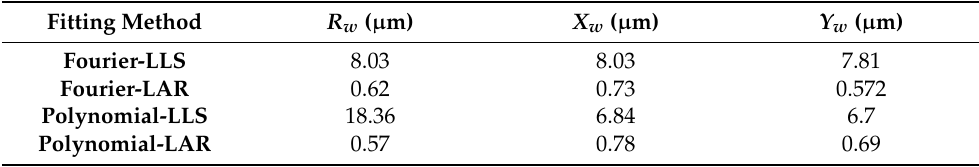
Table 1. The RMSE of measurement parameters.